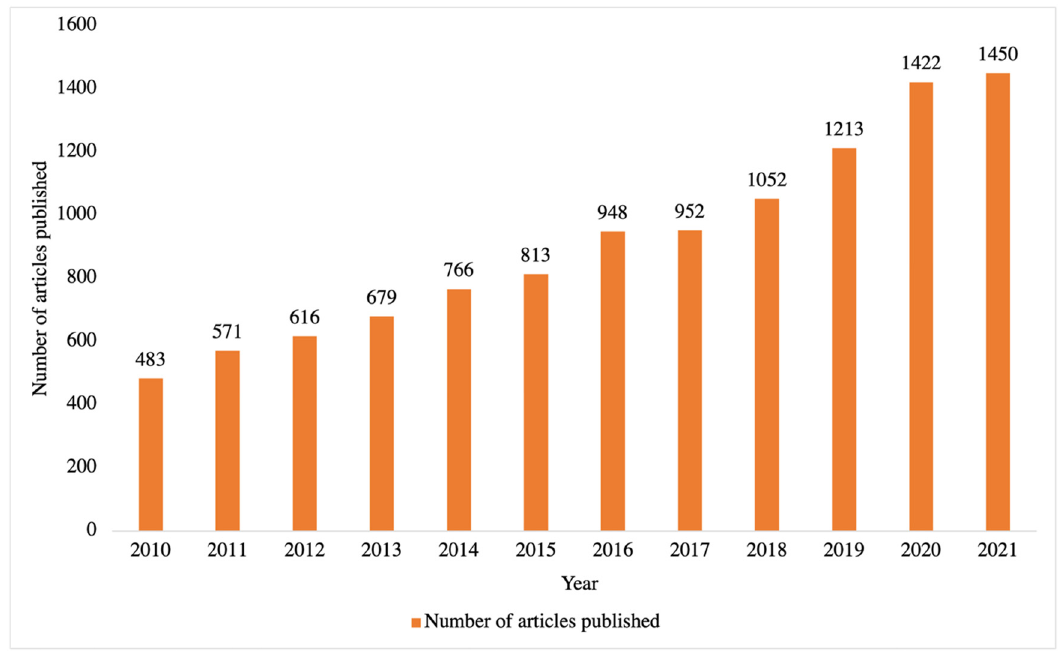
Figure 1: Number of publications on bacterial cellulose since 2010 – 2021. Scopus search engine system, the search term “ bacterial cellulose.